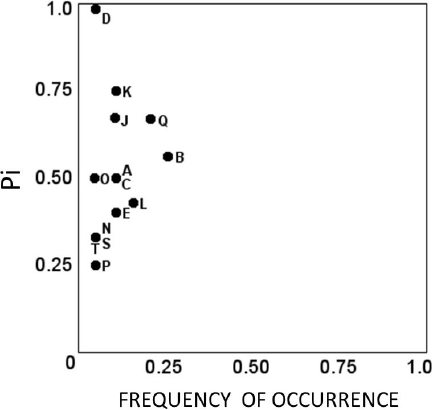
Figure 3 - Relationship between the mean volume of prey (mm 3 ) and the jaw width (mm) of individuals of Haddadus binotatus population from an Atlantic Rainforest area in the state of Espírito Santo, southeastern Brazil ( r = 0.6025; s P = 0.0063, n =